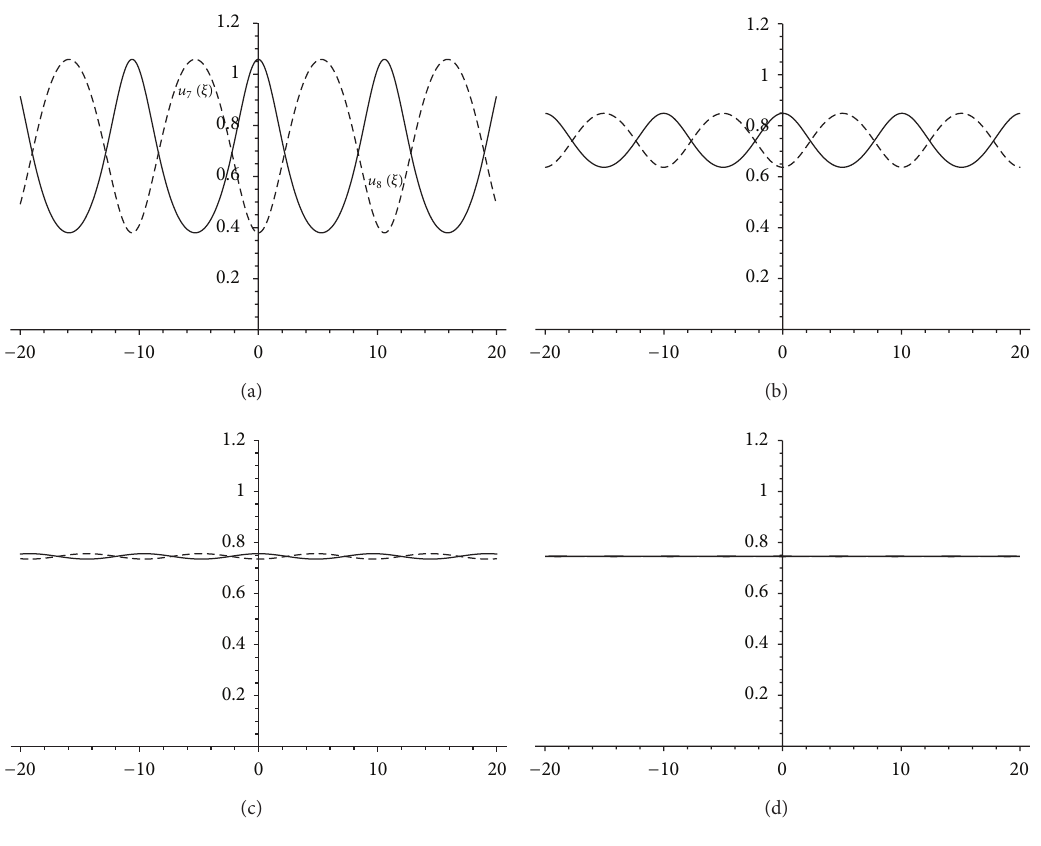
Figure 2: The varying process for graphs of 𝑢 7 (𝜉) and 𝑢 8 (𝜉) when 𝑐 > 𝛼 and 𝑔 → −𝑔 0 +0 where 𝛼 = 𝛽 = 𝛾 = 1 , 𝑐 = 2 , and (a) 𝑔 = −𝑔 0 +10 −1 . (b) 𝑔 = −𝑔 0 + 10 −2 . (c) 𝑔 = −𝑔 0 + 10 −4 . (d) 𝑔 = −𝑔 0 + 10 −6